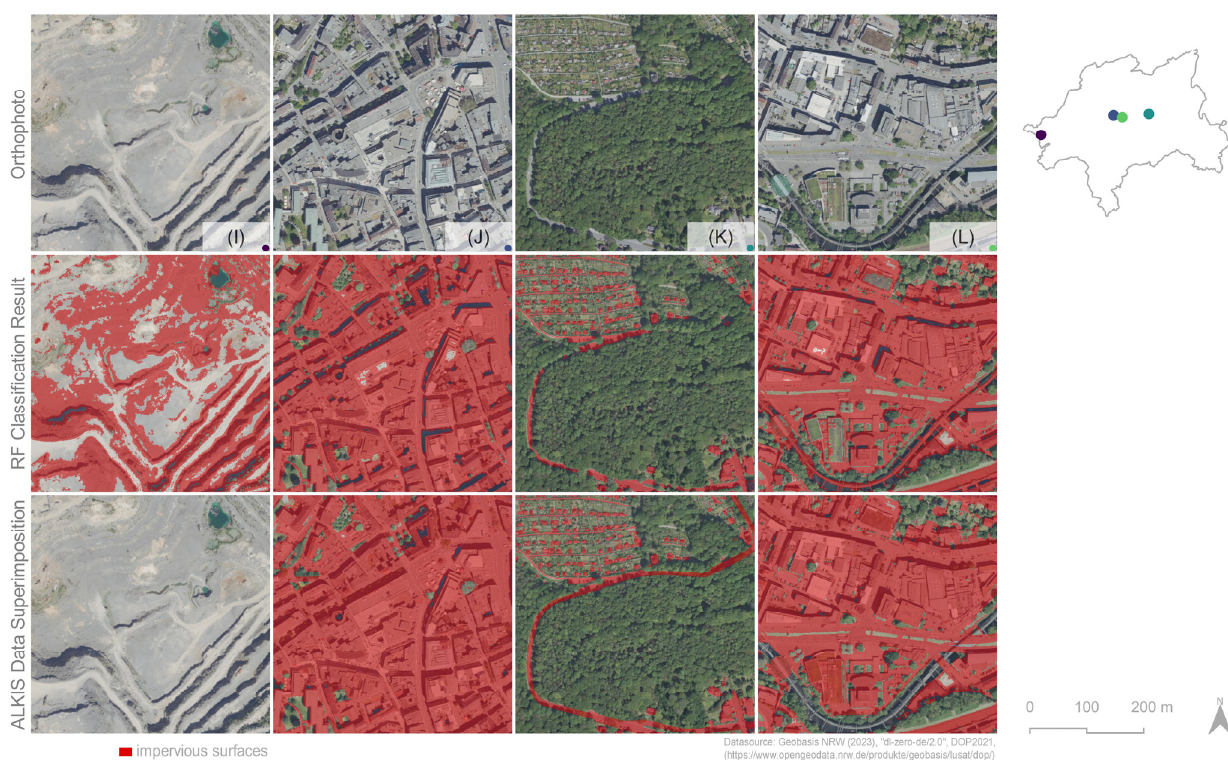
Figure 11. Factors of under- and overestimation of land sealing: quarry areas (I), shaded areas (J), obscured areas by tree canopy (K), green roofs and civil engineering structures (L). The RF model was able to distinguish bare soil surfaces from impervious